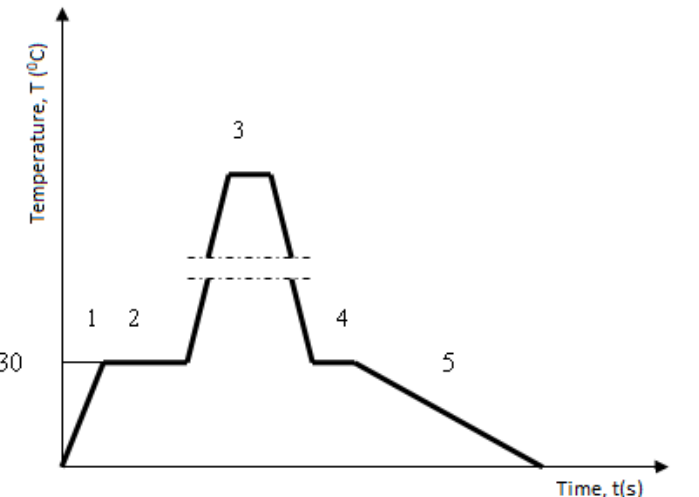
Figure 3. Diagram of the heat treatment regime during the hard-facing: 1 — slow heating in the oven; 2 — holding at the preheating temperature (T = 230 °C, t = 2 h); 3 — hard-facing; 4 — returning to the furnace (T = 230 °C, t = 1 h); 5 — slow cooling together with the oven.